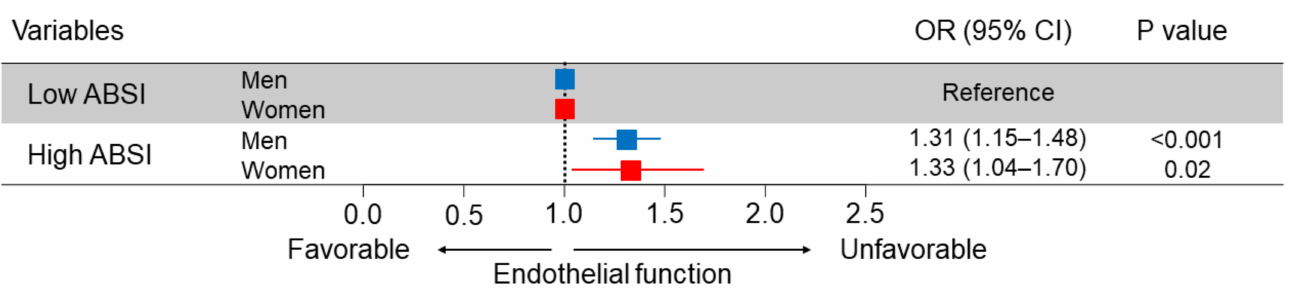
Figure 3. Odds ratios and 95% confidence intervals, adjusted for age, body mass index, presence of hypertension, dyslipidemia, and diabetes, and smokers, for endothelial dysfunction of high ABSI. The subjects with endothelial dysfunction were defined as follows: Men, FMD of less than 3.6%, Women, FMD of less than 3.1%. Low ABSI was defined as follows: Men, less than 0.0796, Women, less than 0.0823. Adapted from [28] 2021 Springer Nature